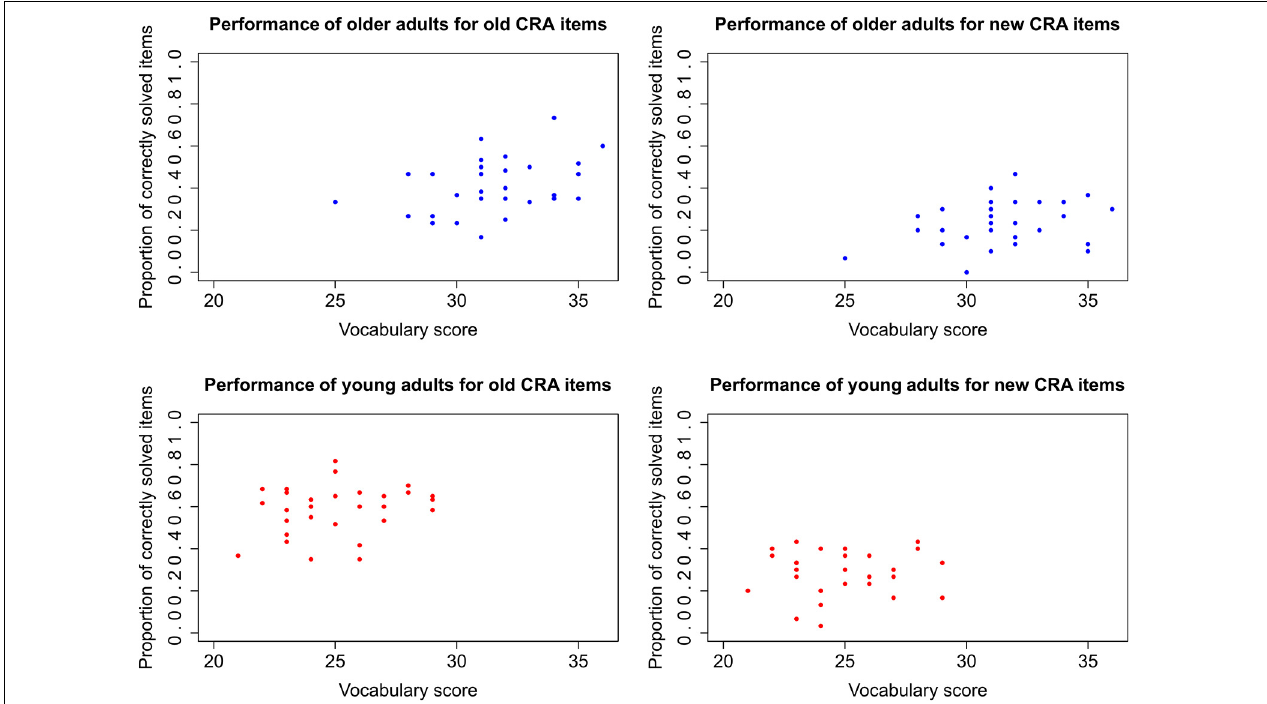
FIGURE 4 | Correlation between score of vocabulary test (MWT-B) and frequency of correctly solved CRA items.